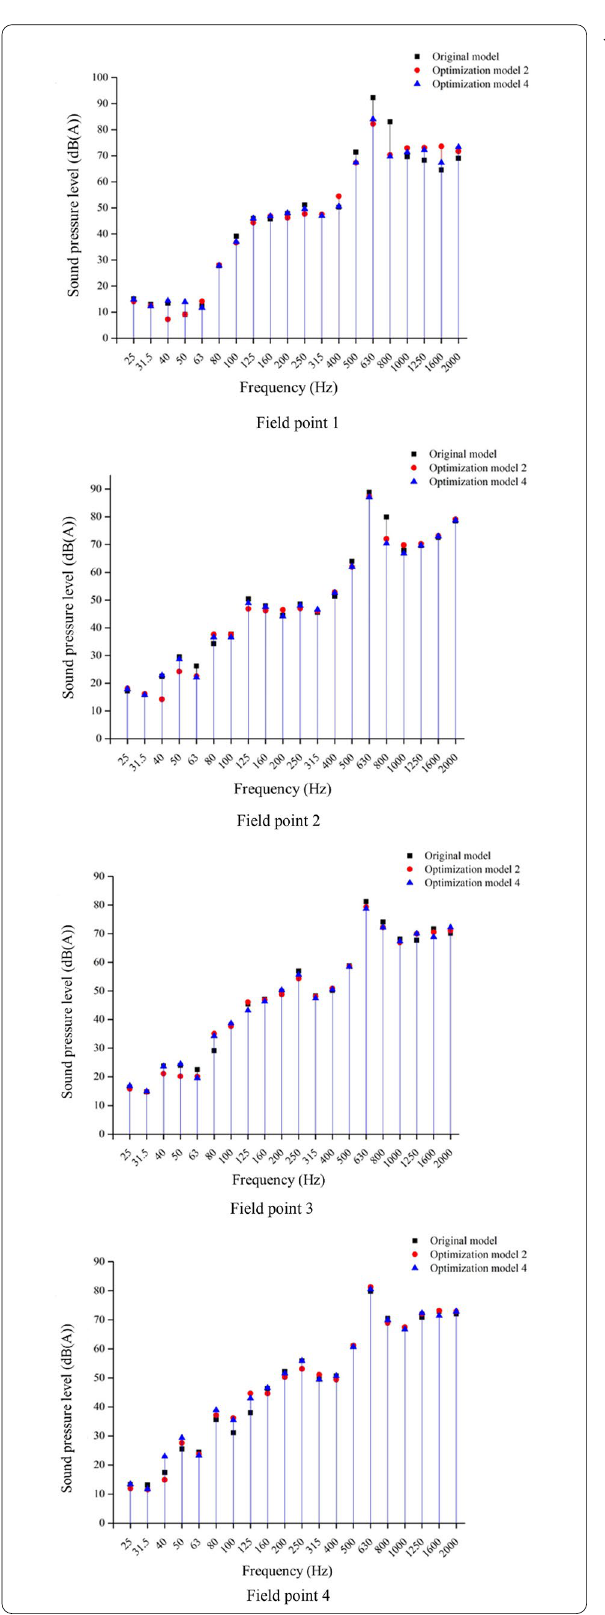
Figure 17 The measured value of A-weighted 1/3 octave sound pressure level of radiated noise at each field point